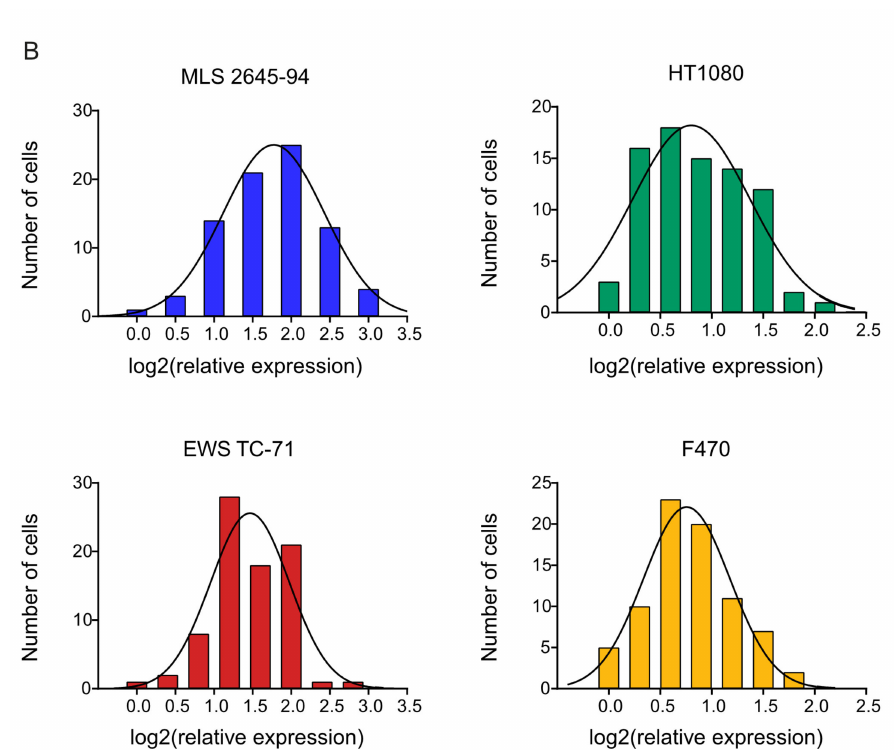
Figure 3. Cell heterogeneity in total polyadenylated RNA levels. ( A ) Total polyadenylated RNA levels in single cells and 32 cells from myxoid liposarcoma (MLS) 2645-94, HT1080, Ewing sarcoma (EWS) TC-71, and F470, expressed as relative quantities normalized to the mean expression of all F470 cells. Mean ± SD is indicated, n = 78–81 (1 cell), n = 3 (32 cells). ( B ) Histograms of total polyadenylated RNA levels among single cells from MLS 2645-94, HT1080, EWS TC-71, and F470. The solid line indicates the Gaussian curve fit. n =